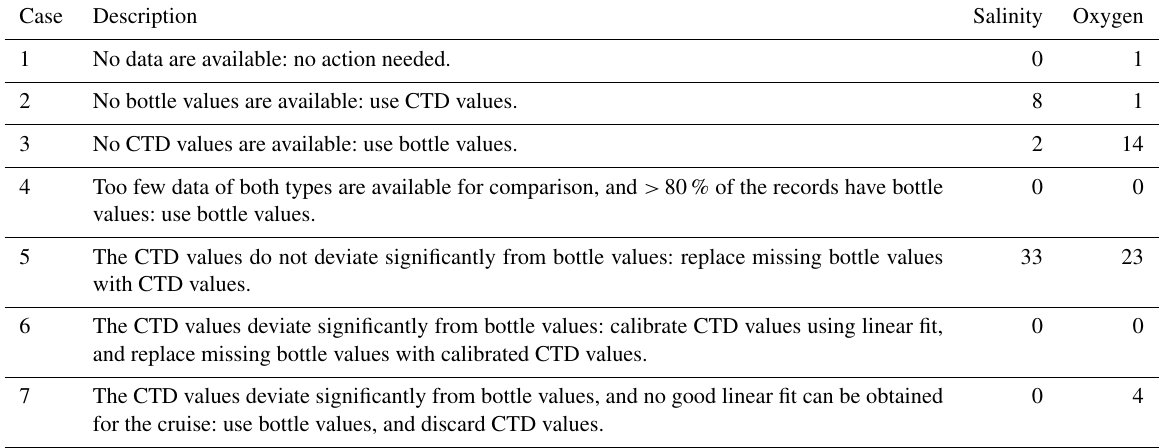
Table 4. Summary of salinity and oxygen calibration needs and actions; number of cruises with each of the scenarios identified.